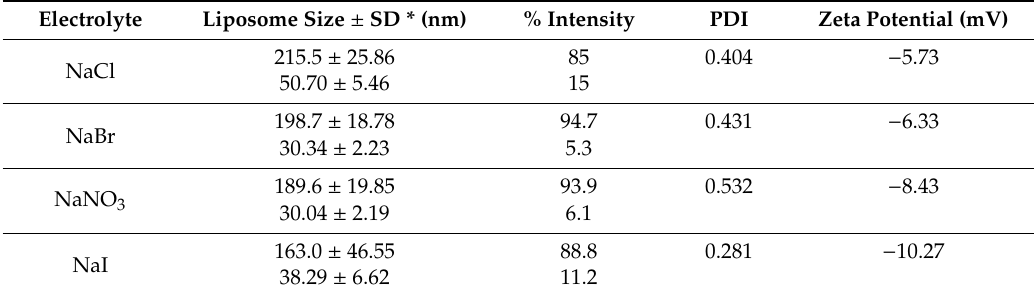
Table 1. Size, polydispersity, and zeta potential of phosphatidylcholine liposomes dispersed in di ff erent anionic media with concentration 155